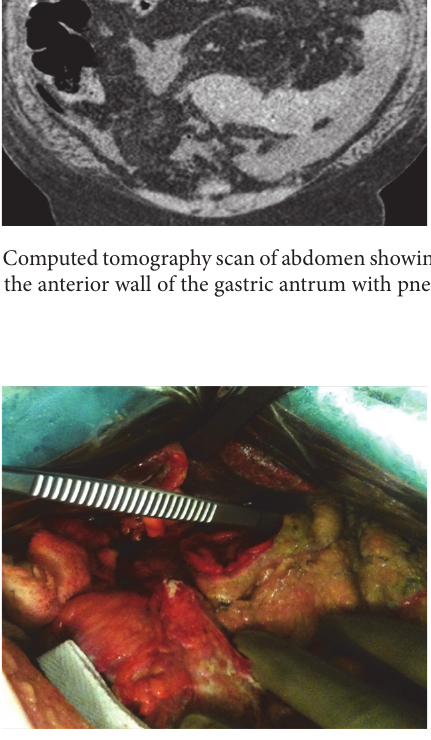
Figure 2: Operative picture showing giant gastric